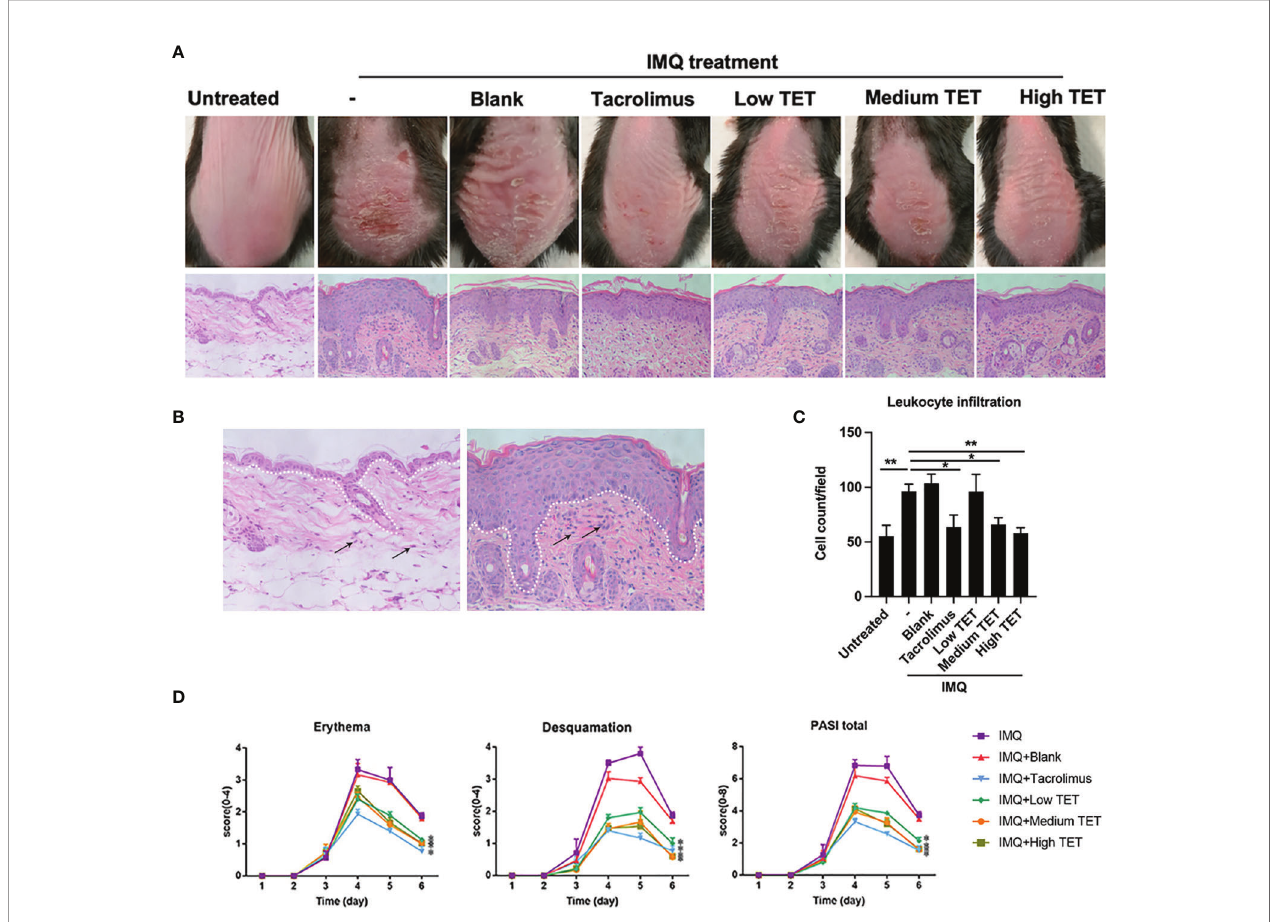
FIGURE 4 | TET NE ameliorates skin lesion in IMQ-induced psoriasis mice. WT mice (N = 9) were treated with IMQ for 6 days. TET NE treatment starts from the second day after IMQ treatment for 5 days. 24 hours later, the mice were sacri fi ced. (A) Representative images of IMQ-induced psoriasis-like lesions and representative H&E staining of skin sections. (B) The white dotted line distinguished the epidermis (over the dotted line) from the dermis (below the dotted line). (C) Dermal in fl ammatory in fi ltrates on H&E staining (400×) were calculated with Image J software. (D) Clinical scores were assessed to monitor disease severity, including erythema, desquamation, and total PASI scores. Data were shown as means ± SEM. -: IMQ without treatment; Blank: IMQ + blank gel treatment. * P < 0.05, ** P < 0.01, compared with IMQ